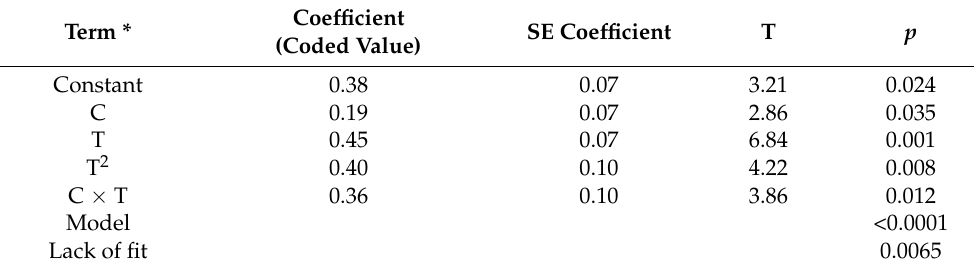
Table 5. Estimated regression coefficients for cellulose/hemicellulose response. Coefficient Term * (Coded